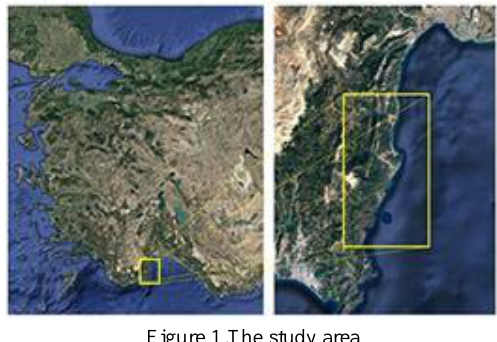
Figure 1.The study area